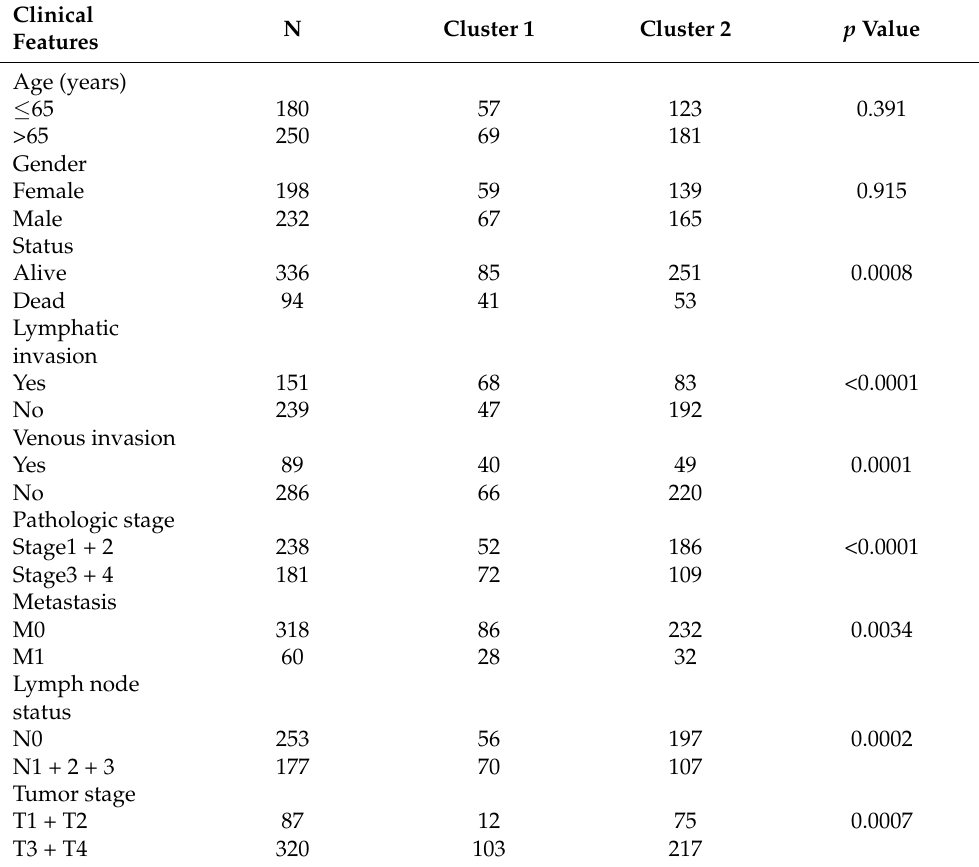
Table 1. Correlation of two cluster groups with clinicopathological parameters based on TCGA CRC